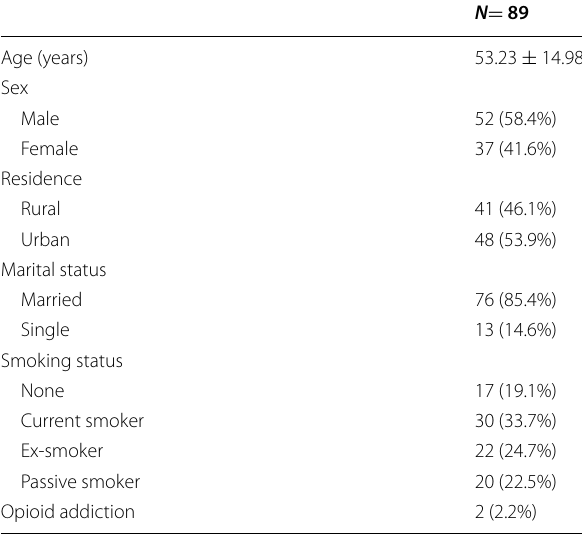
Table 1 The baseline data of enrolled patients